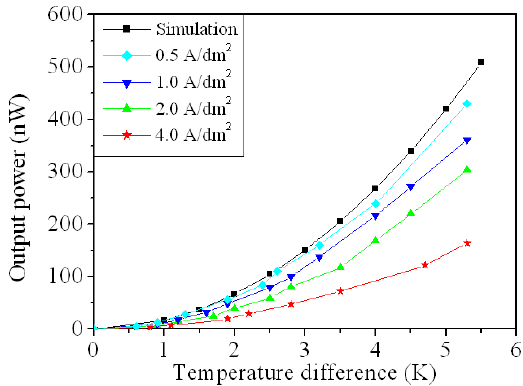
Figure 11. Output power of the flexible thermoelectric generator at different current density.